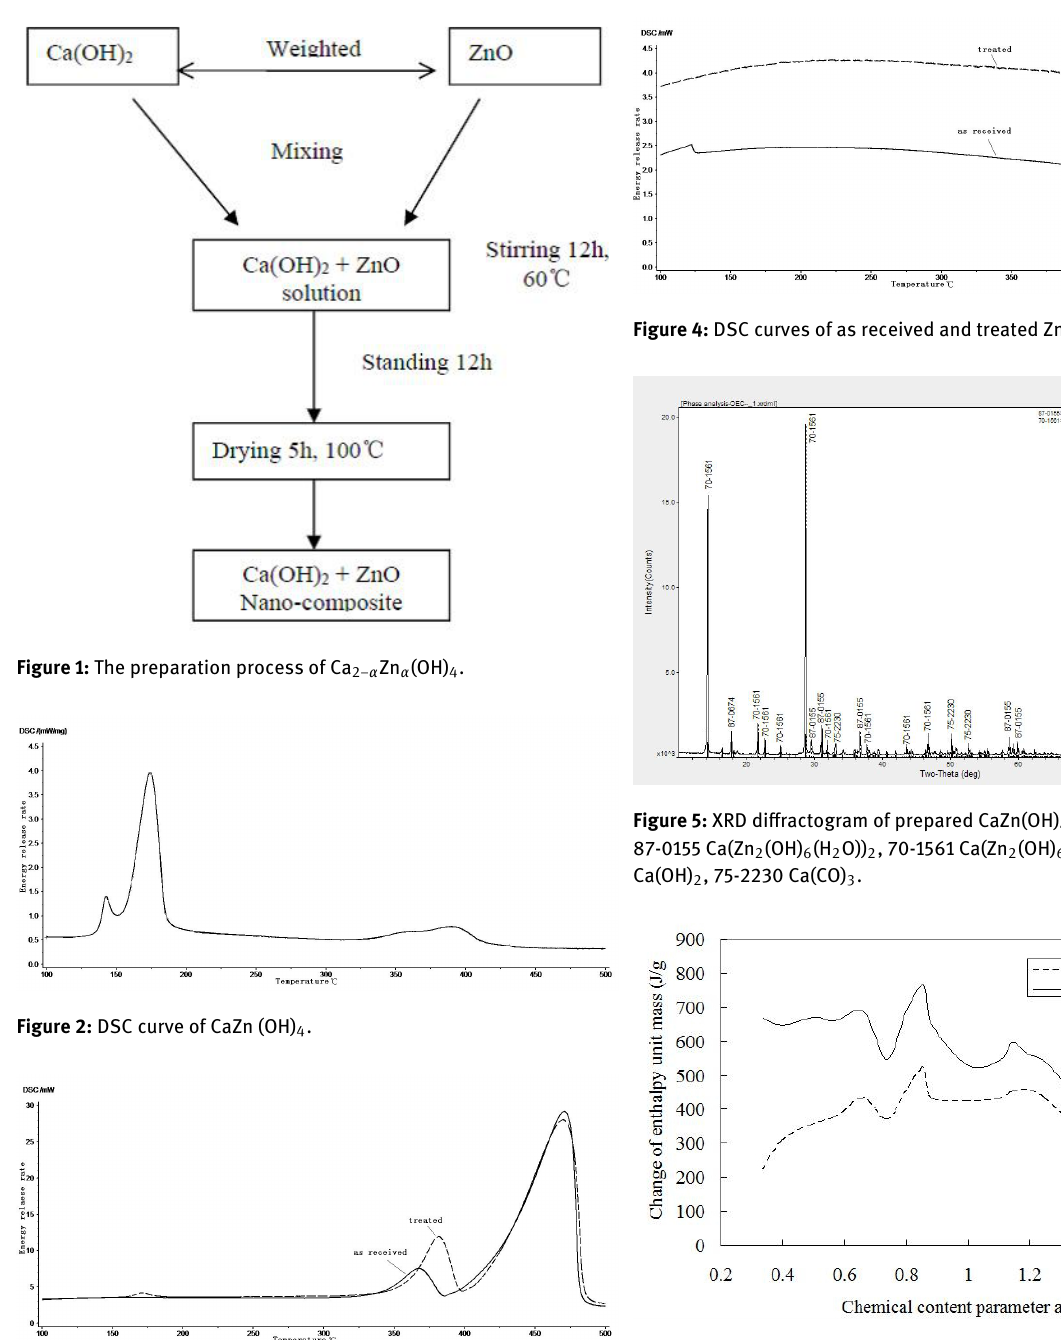
Figure 6: Variation of the thermal storage capacity of Ca 2− α Zn α (OH) 4 with respect to chemical content parameter α